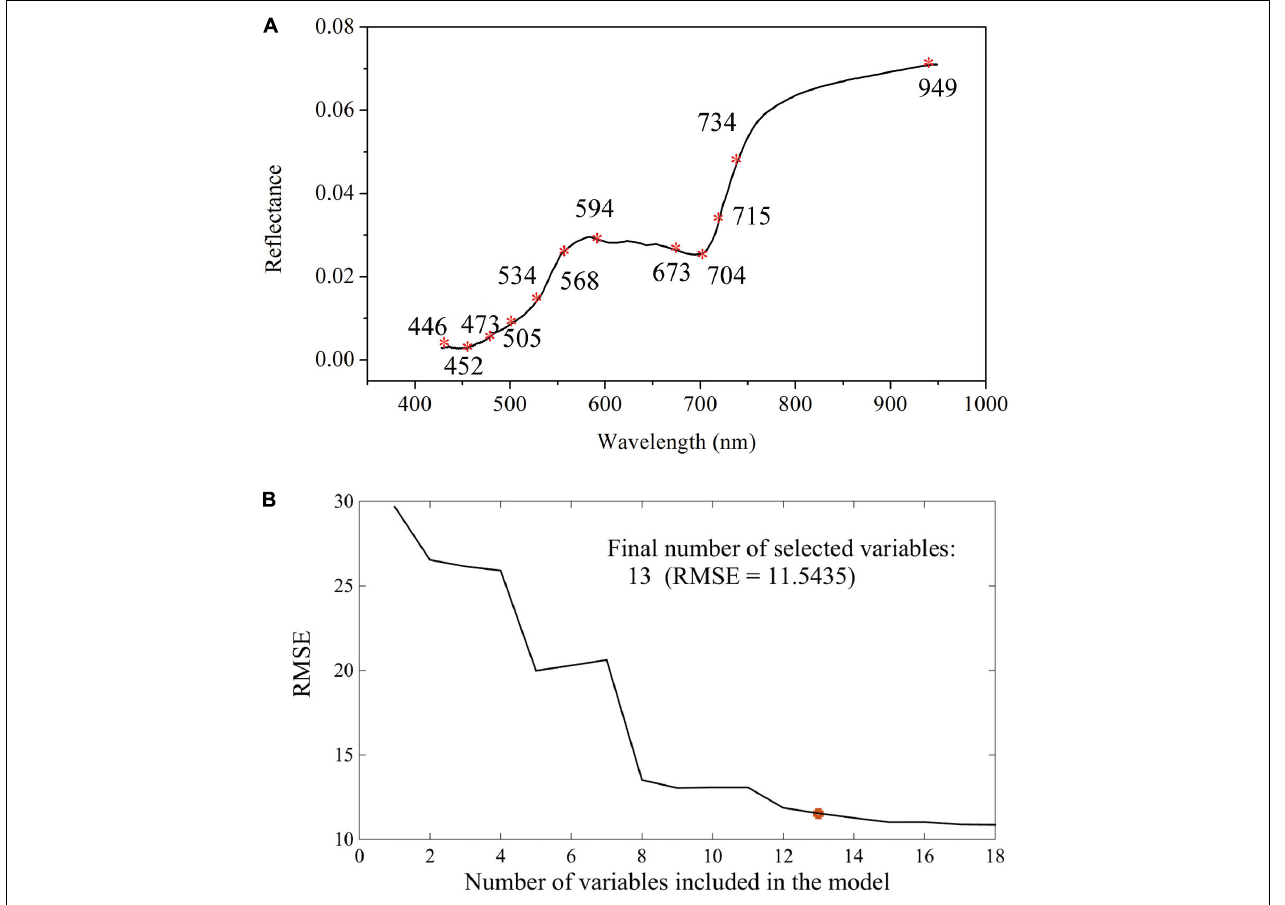
FIGURE 5 | Selection of sensitive wavelengths by the successive projections algorithm: distributions of important variables for shikimic acid concentration (A) ; final number of selected variables determined on the basis of the root mean square error (RMSE) of validation set of multiple linear regression models (B)